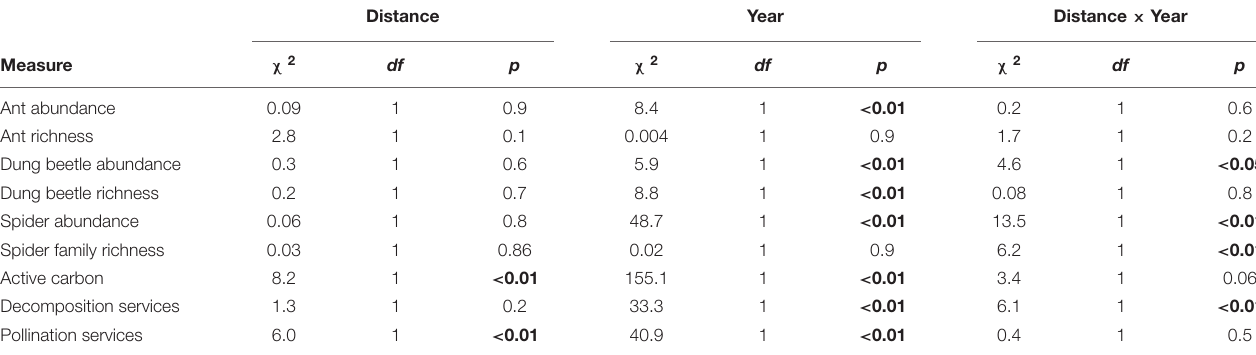
TABLE 2 | Effects of crop management treatments on measures of biodiversity and ecosystem services treatments. Distance Year Distance × Year Measure